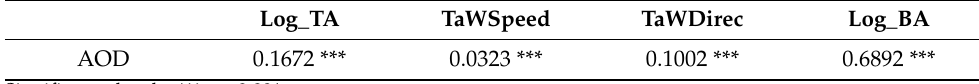
Table 5. Correlation among the instrumental variables and AOD.